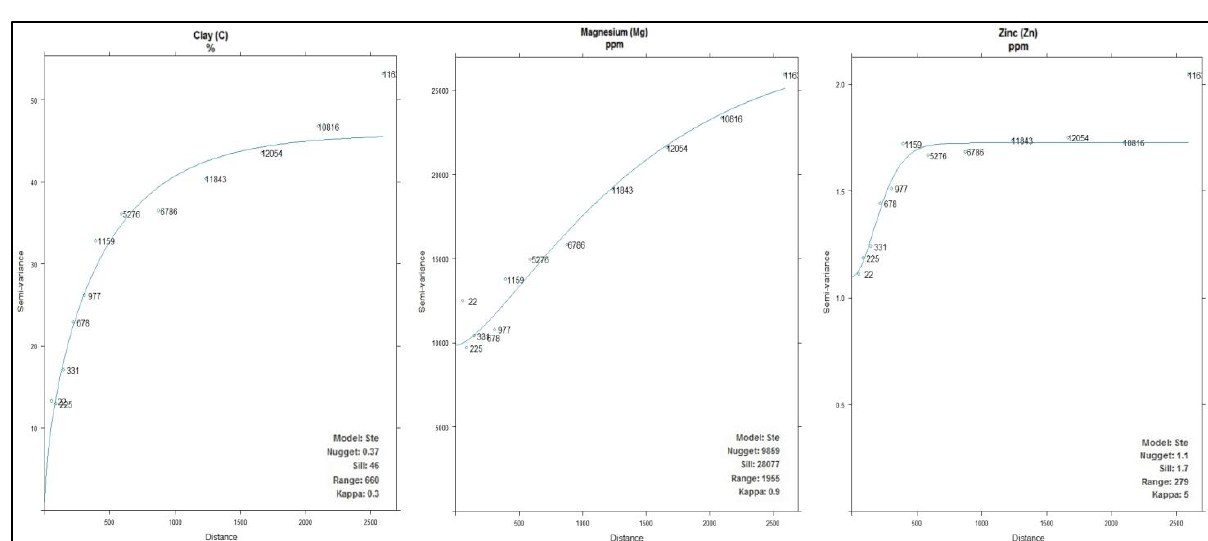
Figure 3. Satellite covariates of the study area.